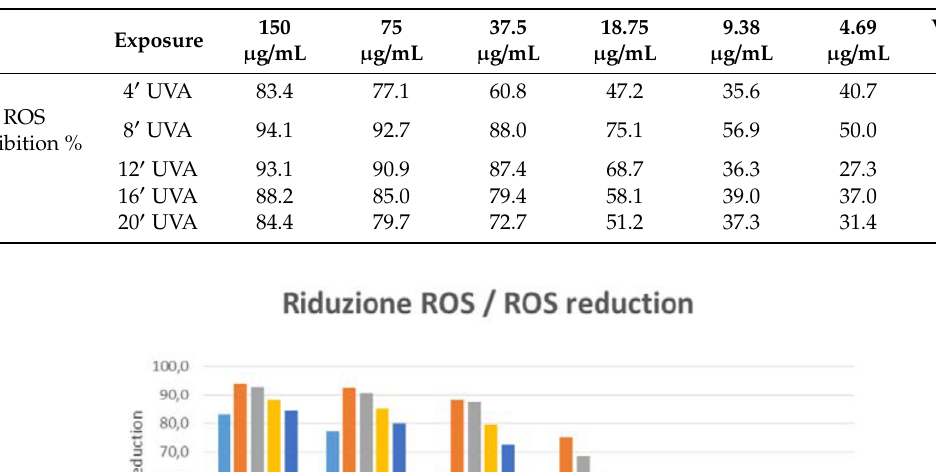
Table 3. ROS Inhibition % induced by the active ingredient at different concentrations.